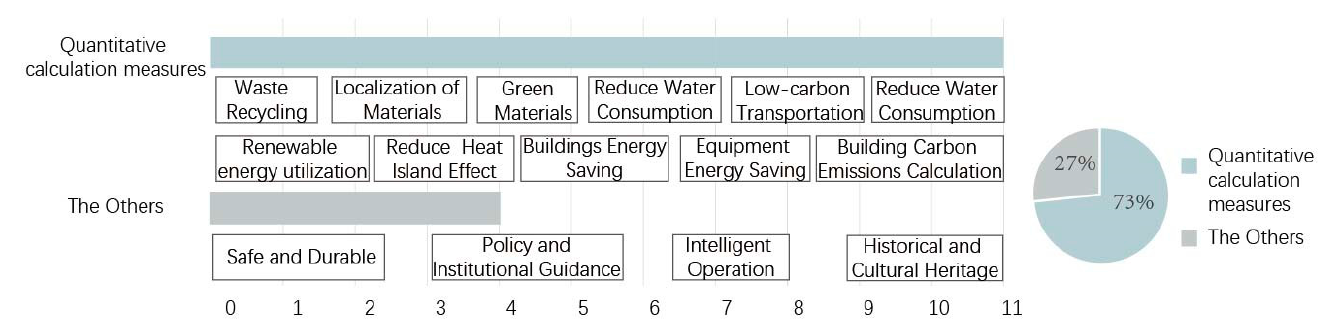
Figure 11. Analysis of qualitative and quantitative items.